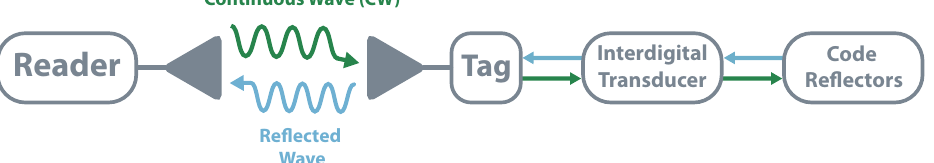
Figure 10. Schematic of a Time Domain Reflectometry system using Surface Acoustic